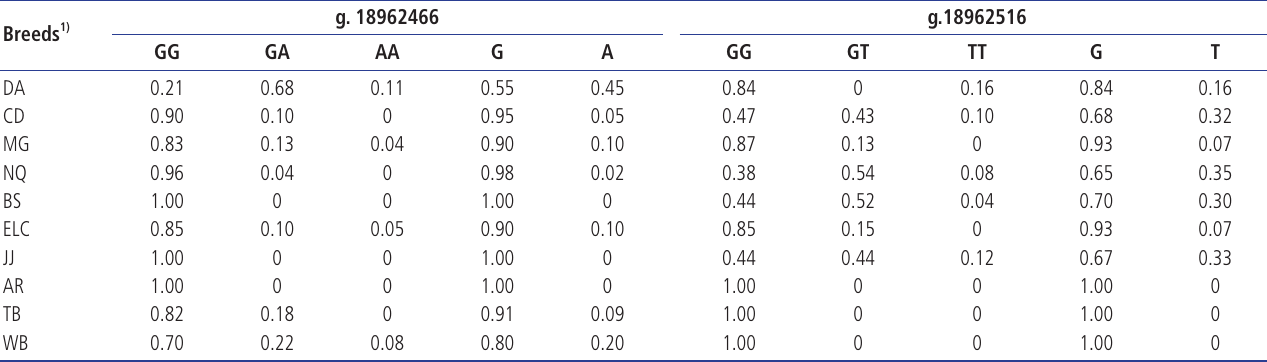
Table 4. The allele and genotype frequencies for the polymorphisms of eCG β gene in the studied breeds Breeds 1)